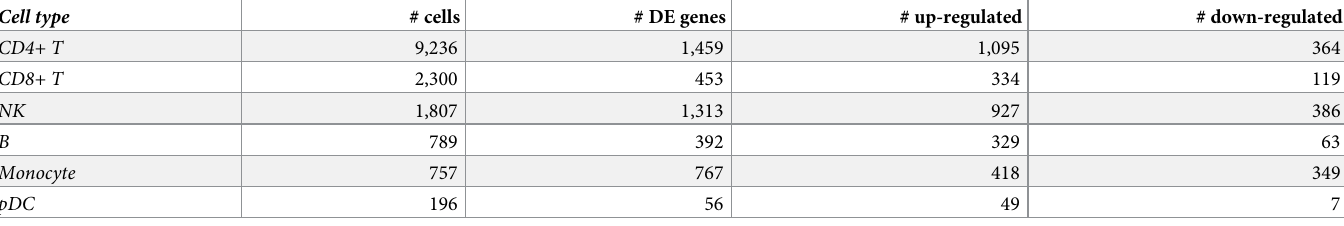
Table 1. Differentially expressed genes per cell type within PBMC single-cell RNA-seq